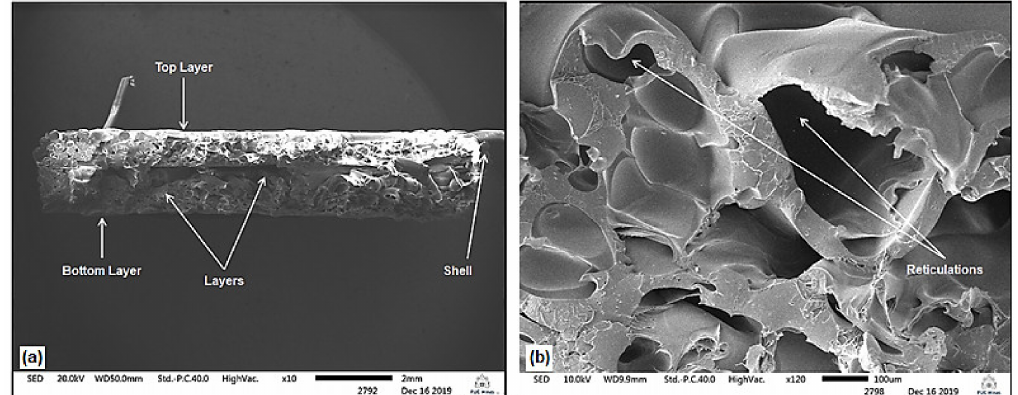
Figure 15. Microstructure images for 25% sample infill: ( a ) the deposition lines of the layers, shell, and top / bottom layer and ( b ) the internal